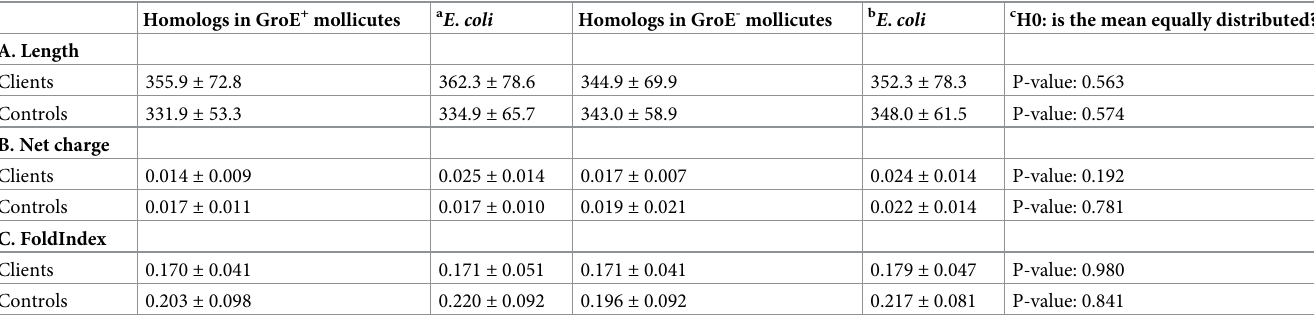
Table 1. Comparing properties of GroE + and GroE -